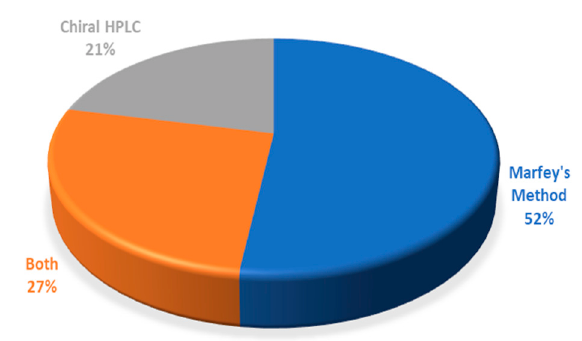
Figure 20. Distribution of the reported studies concerning the determination of the stereochemistry of marine peptides according to the methods used.